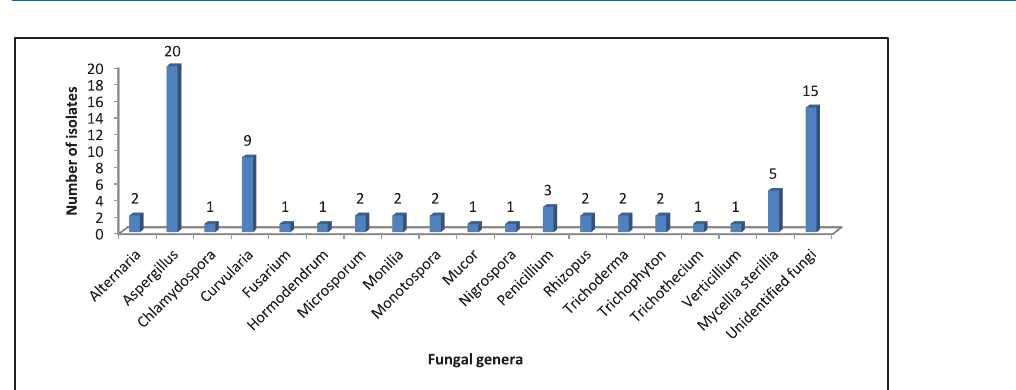
Fig. 1. The fungal genera isolated from soil samples of all three sites